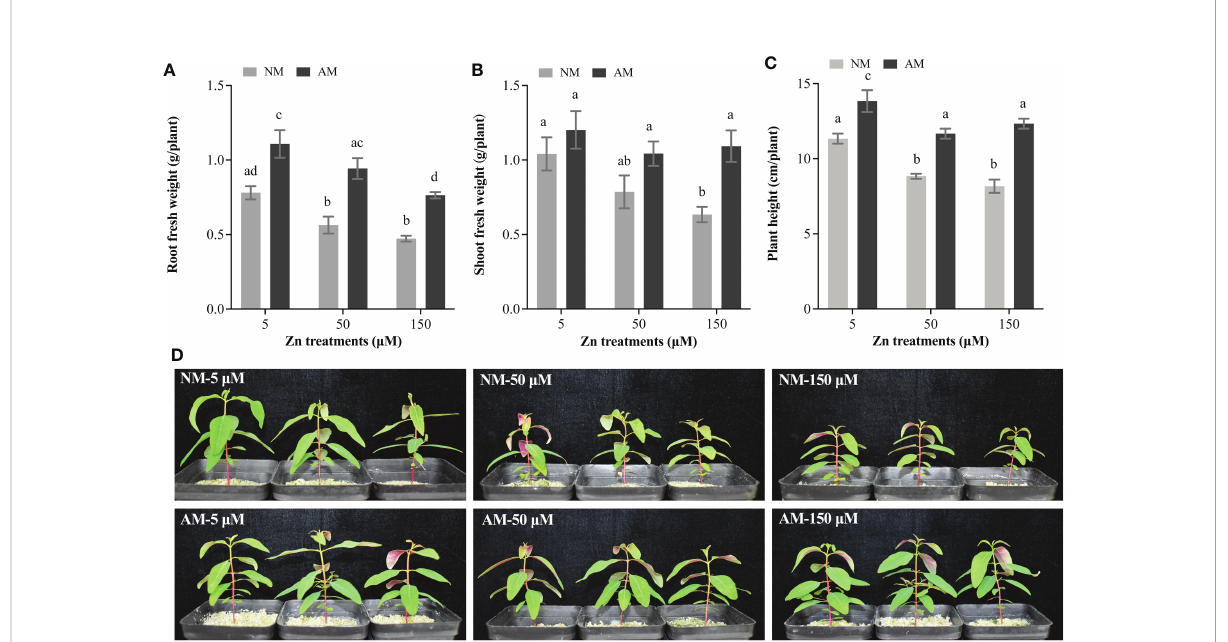
FIGURE 1 Effects of Zn and AM fungi on the growth of E . grandis. (A) Root fresh weight; (B) shoot fresh weight; (C) plant height; (D) the phenotype of E . grandis with or without AM fungi under 5, 50, and 150 m M Zn treatment. NM, non-mycorrhizal plants; AM, mycorrhizal plants. Values were indicated as mean ± SE of six biological replicates. Different letters above bars indicated signi fi cant differences at P <